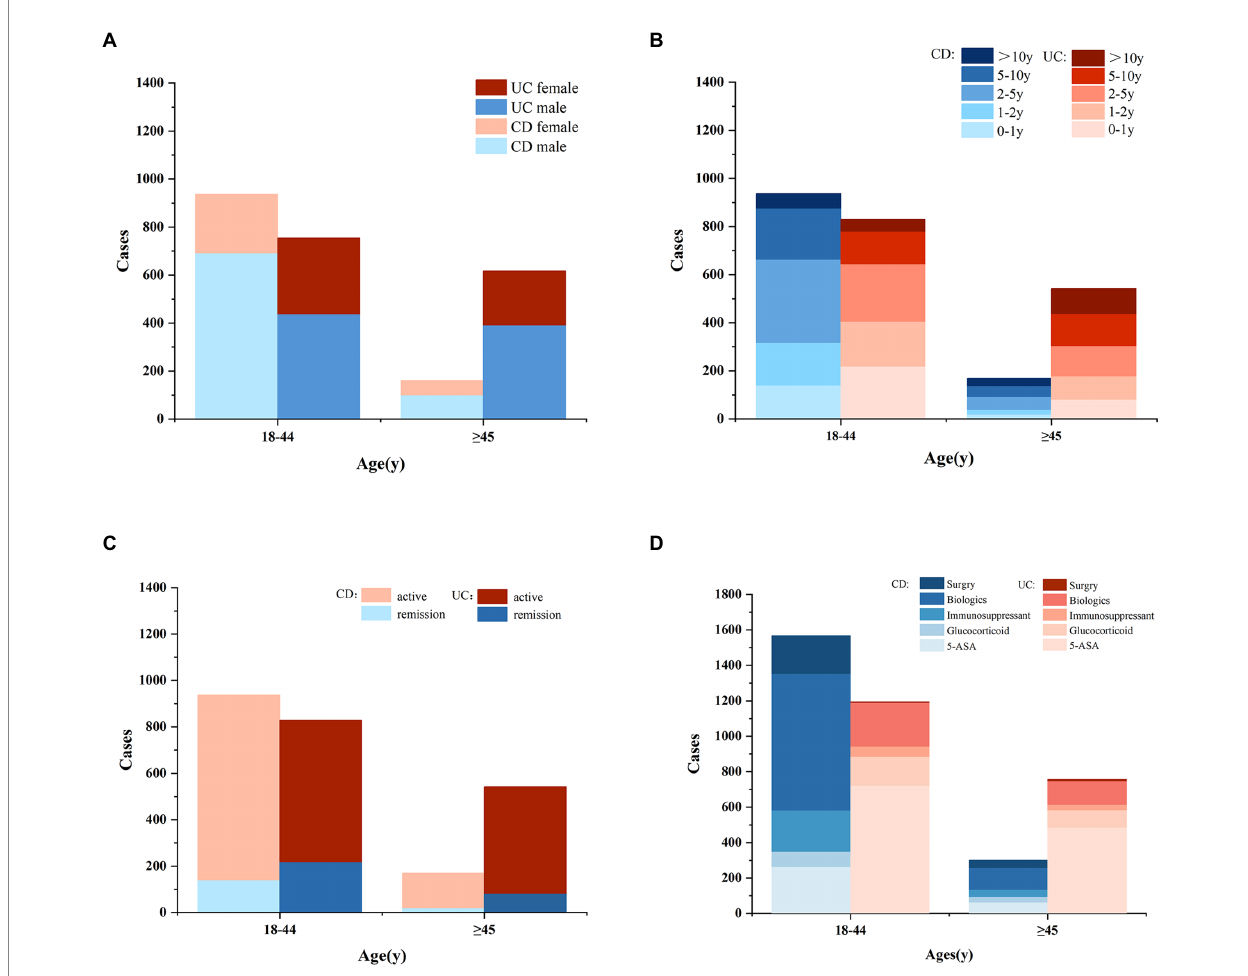
FIGURE 1 The cases of gender (A) , illness duration (B) , disease activity (C) , and prior therapy (D) in IBD patients of different age groups (CD, Crohn’s disease; UC, ulcerative colitis; ASA, amino salicylic acid).